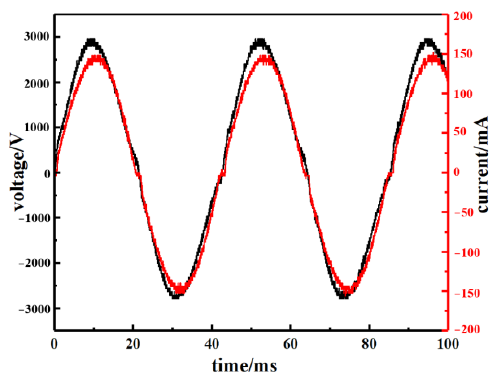
Figure 3. The voltage and current waveforms of Jacob’s ladder arc.